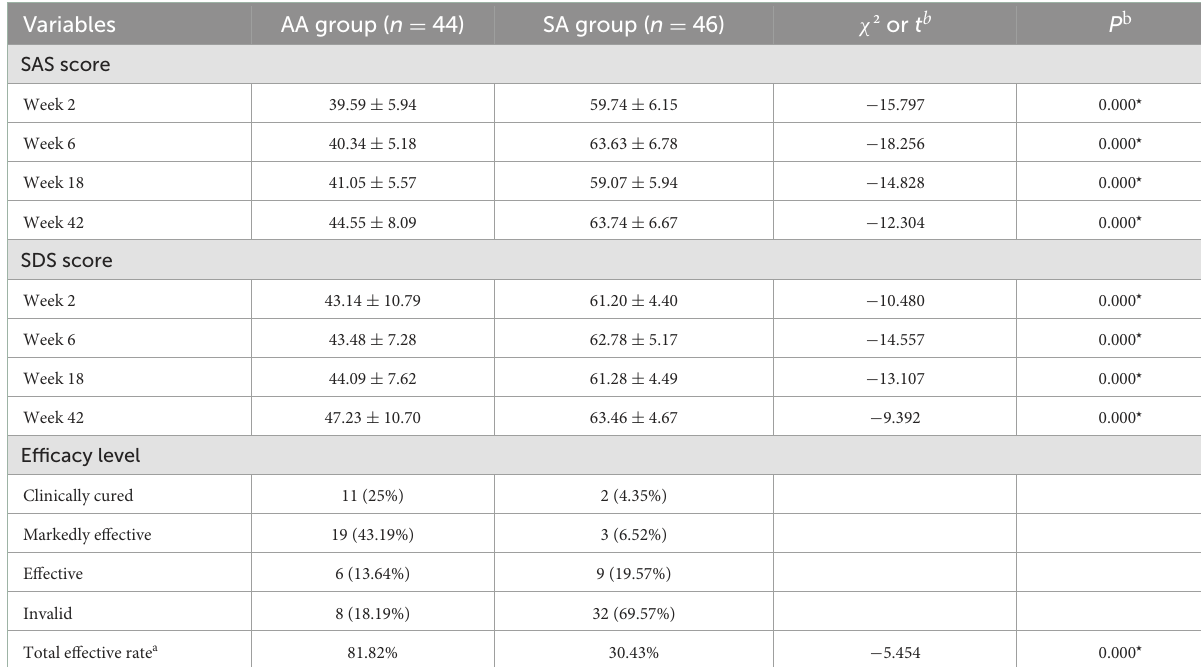
TABLE 5 Secondary outcomes